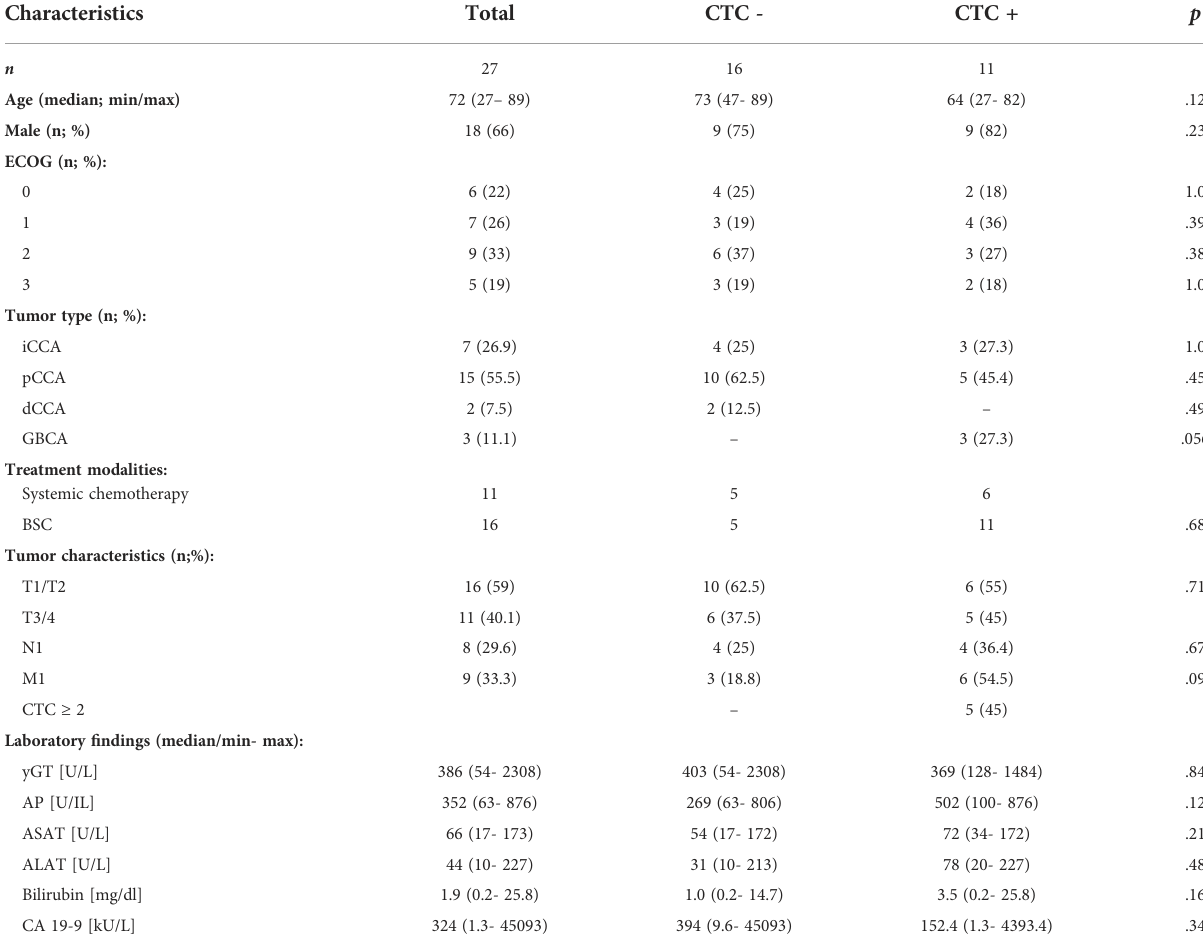
TABLE 1 Baseline characteristics of the feasibility cohort.